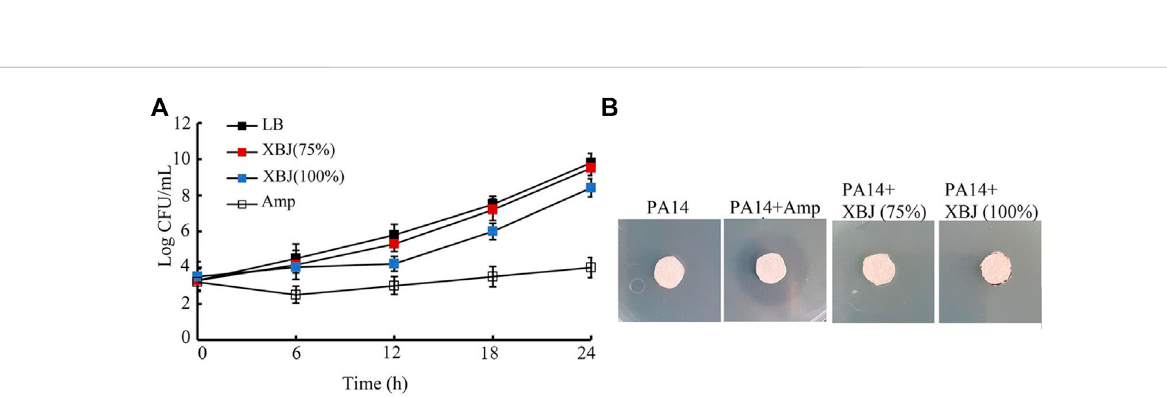
Supplementary Table S4). RNAi of pmk-1 , daf-16 , bar-1 , dbl-1 , egl-1 , and elt-2 caused the similar inhibition on the